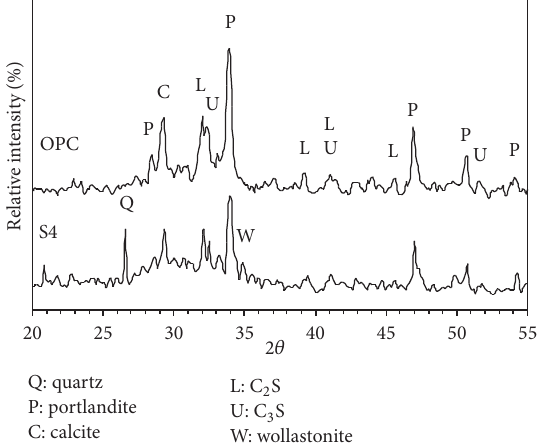
F 8: e compressive strength of sewage sludge ash blended cement paste �red at 200–800 ∘